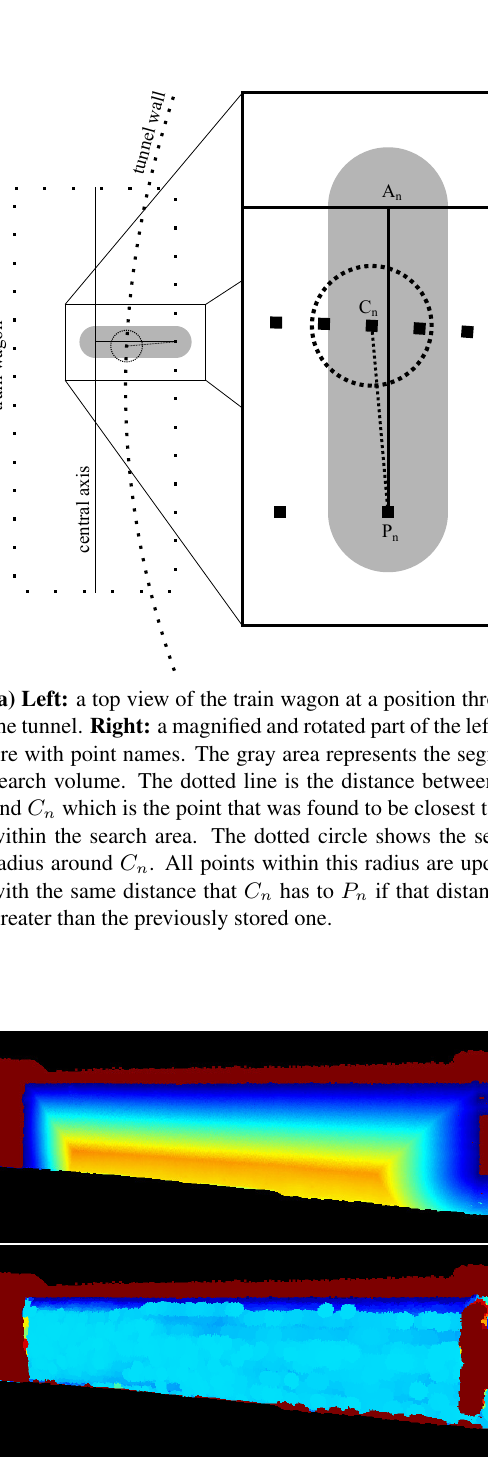
(b) A comparison of the penetration depth as calculated by the two variants. Both figures show a narrow piece of tunnel from the outside with the calculated penetration depth indi- cated by the point color. Non-colliding points are shown in dark red. The top figure shows the simple and fast